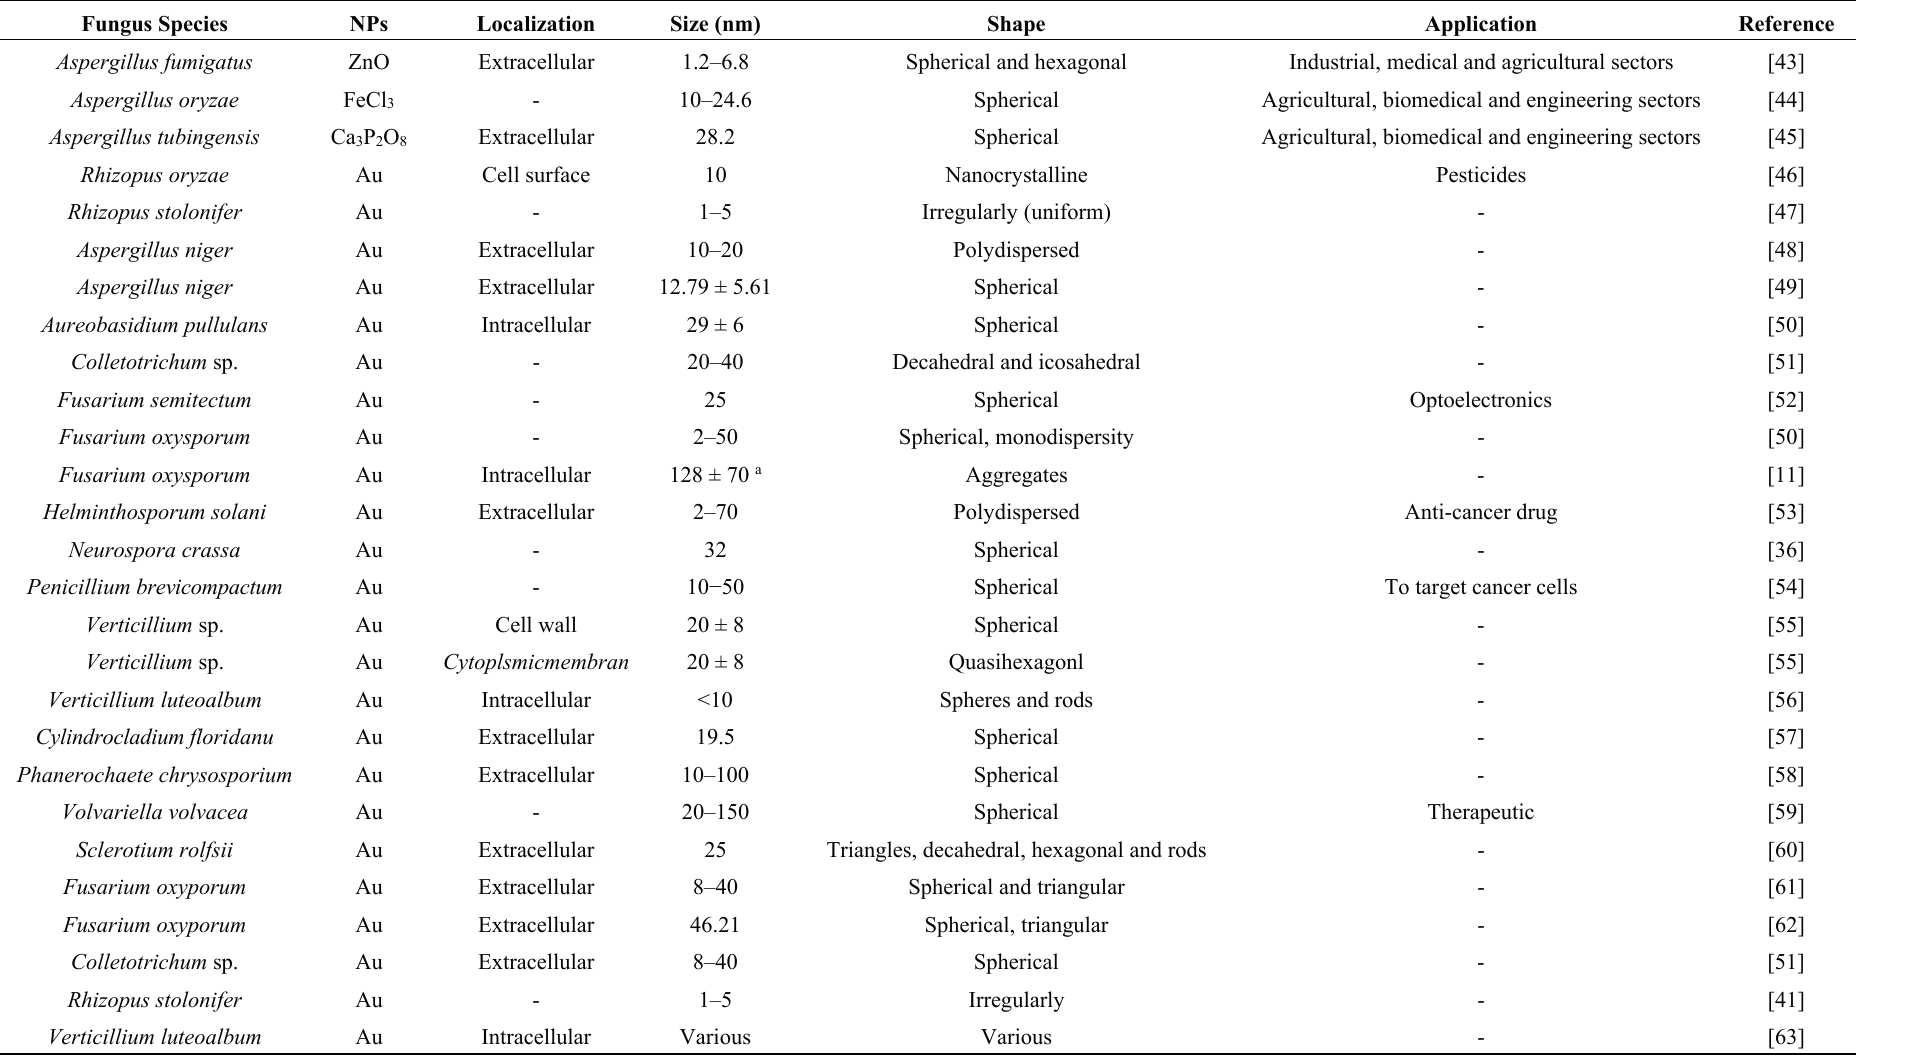
Table 2. Potential fungal isolates used for the biosynthesis of metal/metal oxide